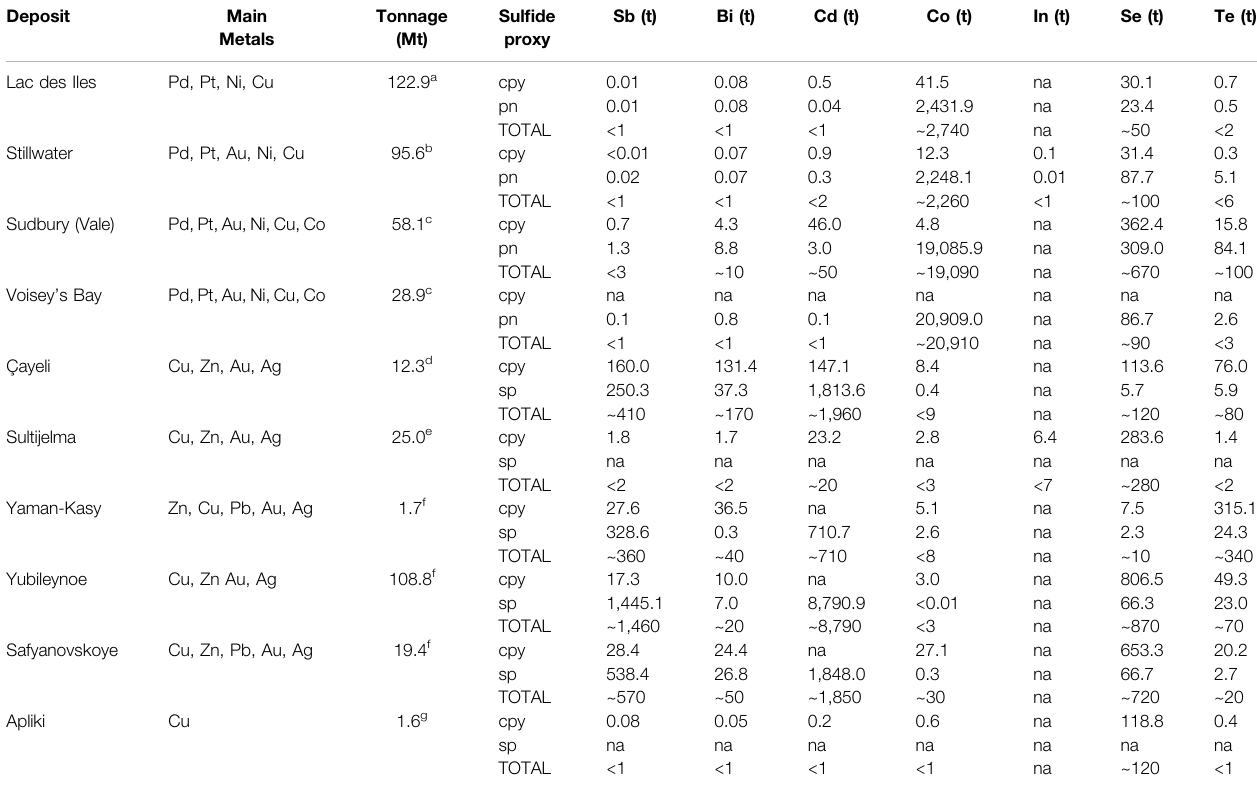
TABLE 4 | Proxy byproduct critical element inventories (t) for select magmatic sul fi de (n=4) and volcanogenic massive sul fi de deposits (n=6).